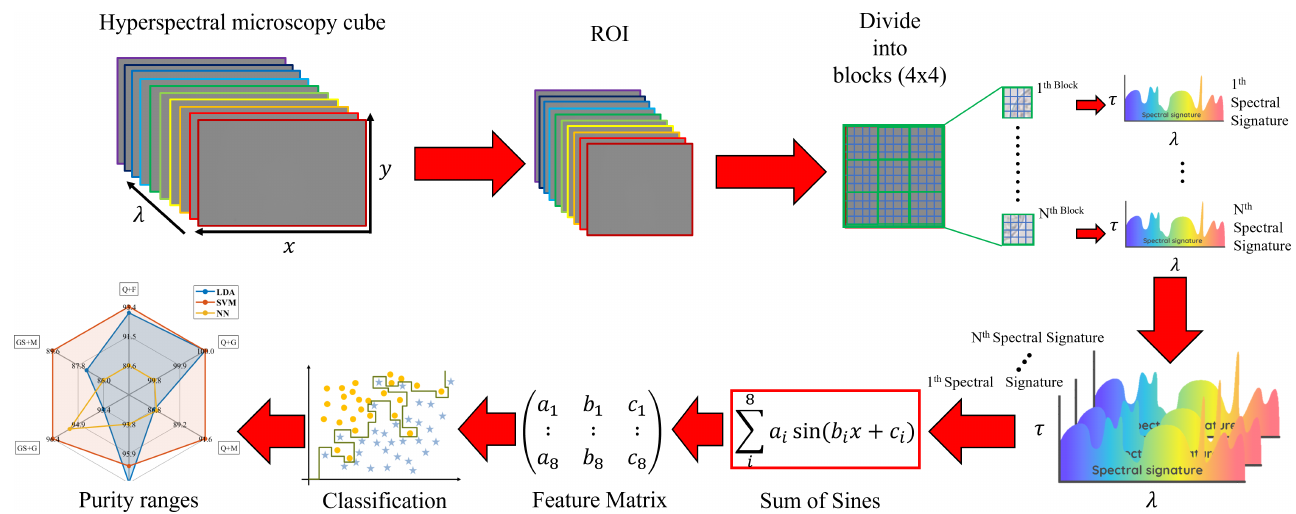
Figure 5. Block diagram of the adulterated honey detection algorithm. Firstly, the transmittance is calculated from each pixel standing in the hypercube’s region of interest (ROI). Then, the ROI is subdivided into 4 × 4 neighborhoods and averaged to create the spectral curves. Secondly, we used the Sum of Sine functions to generate regression coefficients of all the measured spectra. Twenty-four coefficient features were extracted from each spectral curve, which are introduced in the classification section. Thirdly, and finally, we used three classifiers to detect the presence of different syrups on the two kinds of honey and classify them according to their